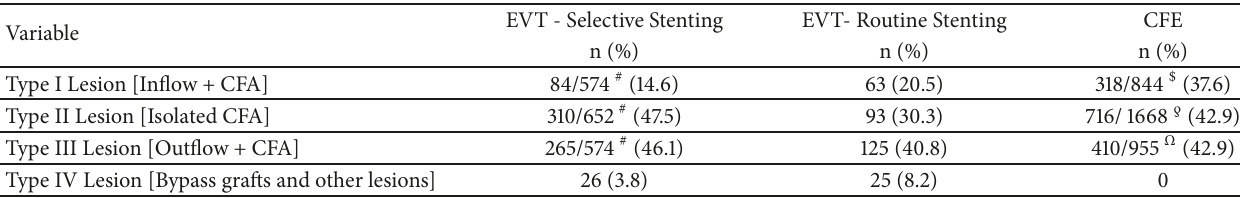
Table 2: Classification of lesions included in the different treatment